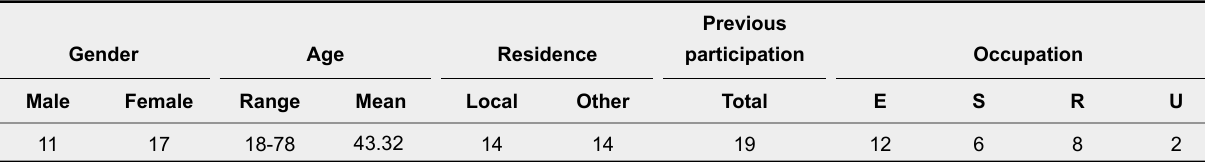
Demography: Gender, Age, Residence, Previous Participation and Occupation OccupationPrevious participationResidenceAgeGender